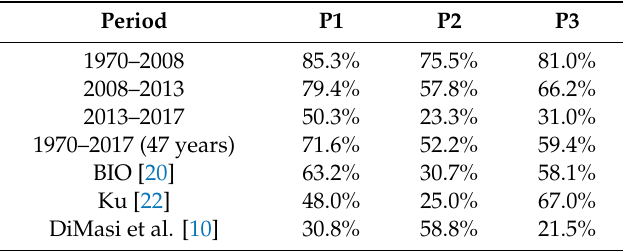
Table 13. POA in each NDA clinical phase for the whole period (1970–2017).